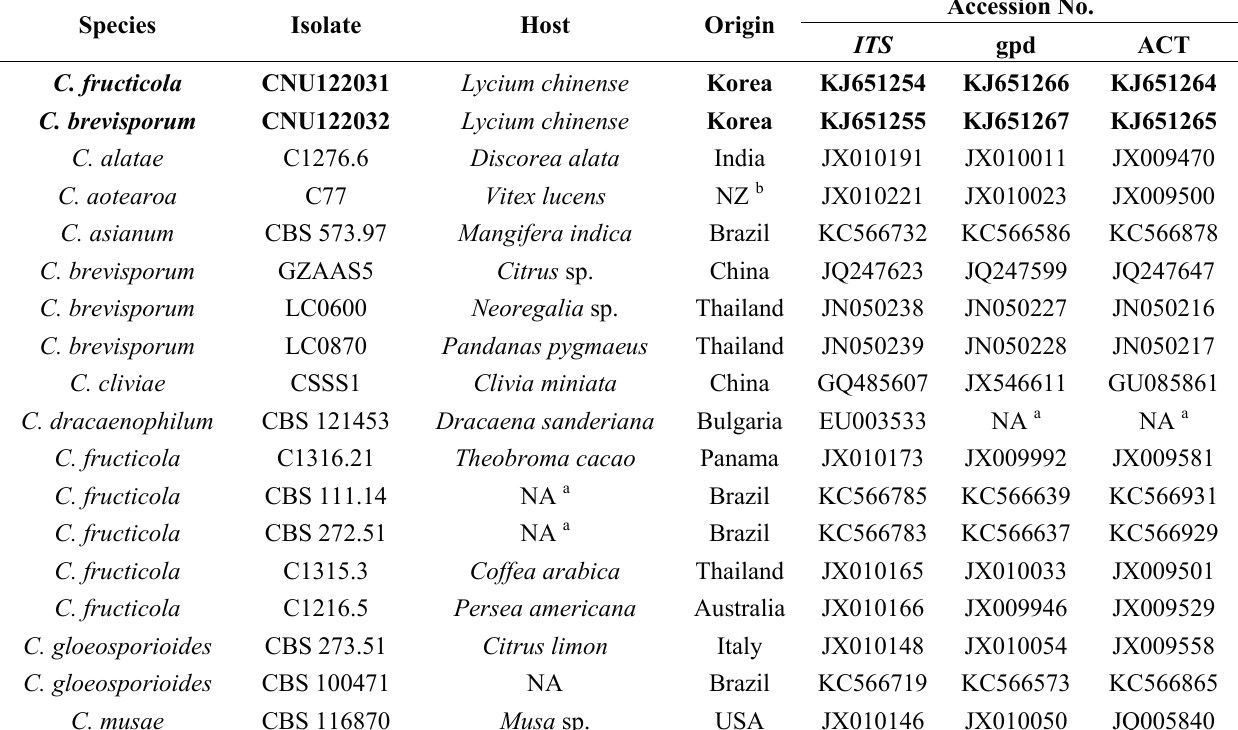
Table 4. Isolates used in this study for molecular data